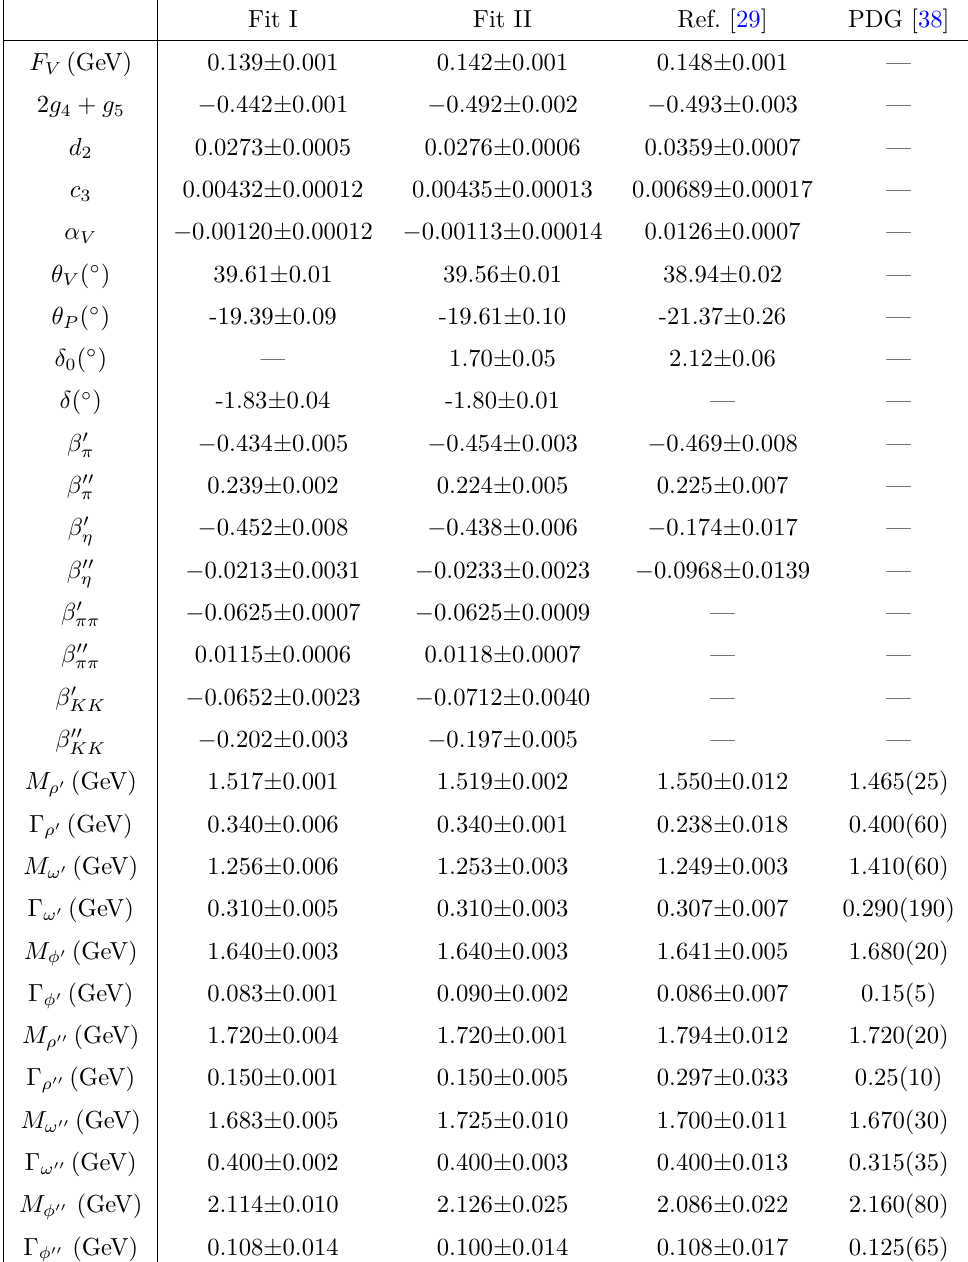
Fitted parameters of Fits I and II compared with the Fit 4 of ref. [29] and PDG [38]. The uncertainty of the parameters are coming from the Bootstrap